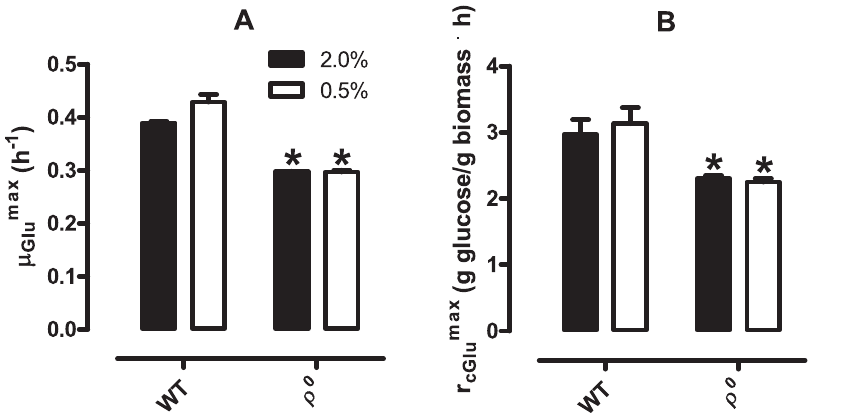
Figure 6. Specific growth rate and specific glucose consumption are decreased in r 0 S.cerevisiae but unaltered by glucose levels. Specific growth rates in glucose ( m glumax , Panel A) and specific glucose consumption (r glumax , Panel B) of WT and r 0 S. cerevisiae (as indicated) were calculated as described in Materials and Methods . * p , 0.05 vs. WT (unpaired Student’s t test).